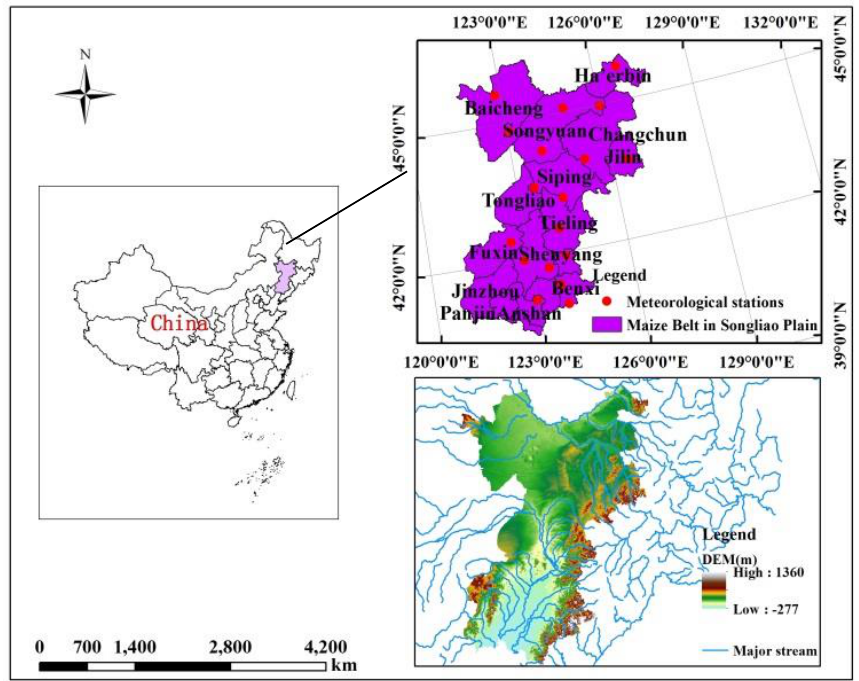
Figure 1. Study area location, meteorological stations, and major river network.